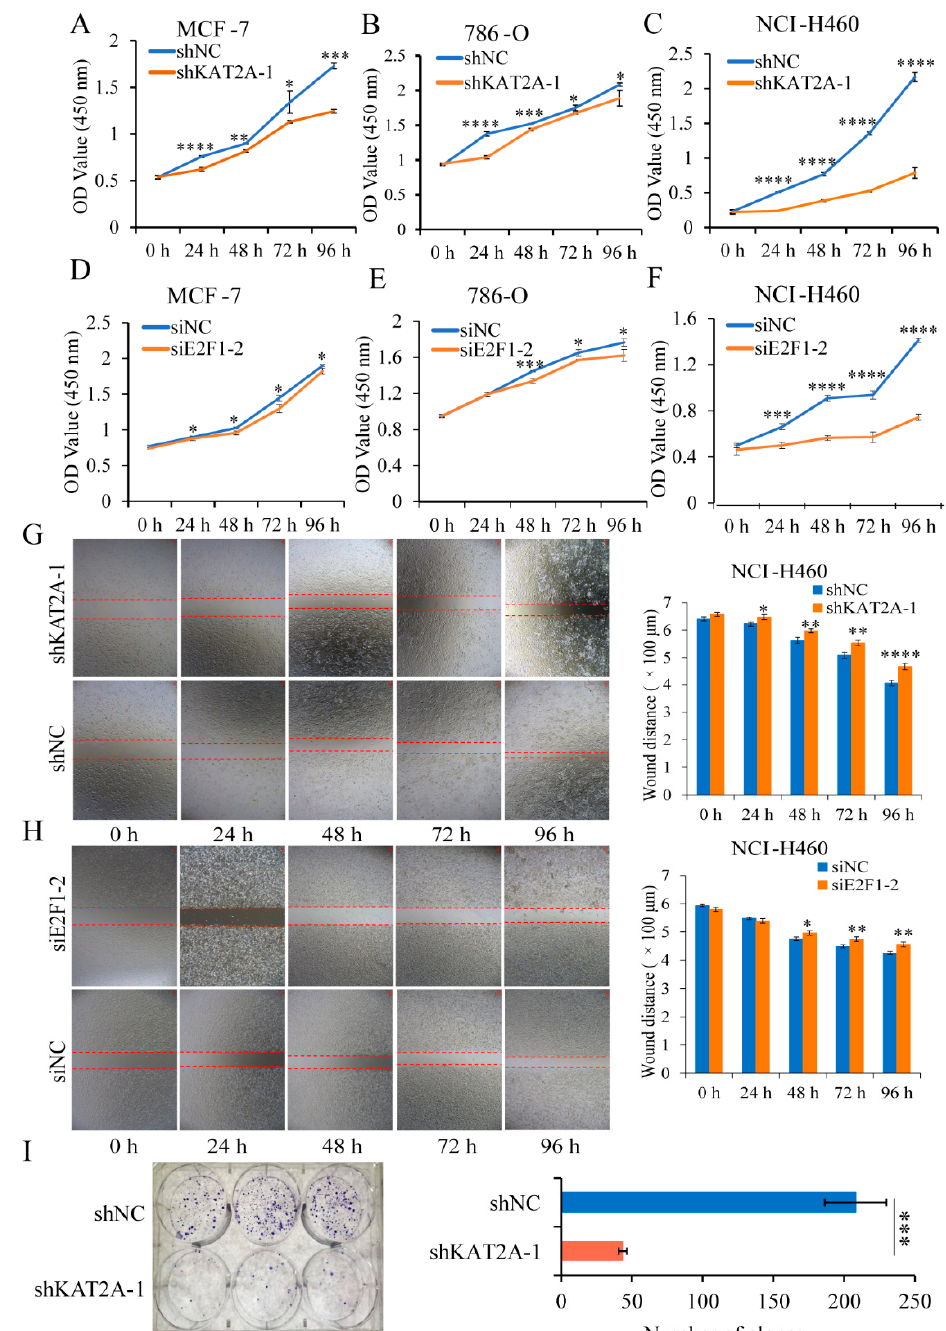
Figure 2. Interfering with KAT2A and E2F1 could significantly inhibit the proliferation and migration of cancer cells. ( A – C ) After transfection of shNC and shKAT2A-1, the cell proliferation ability of MCF-7 ( A ), 786-O ( B ), and NCI-H460 ( C ) were observed using CCK-8. ( D – F ) After transfecting siNC and siE2F1-2, the cell proliferation ability of MCF-7 ( D ), 786-O ( E ), and NCI-H460 ( F ) was detected by CCK-8 assay. Data are representative from at least six independent experiments. The NCI-H460 cells’ migration ability after interference with KAT2A ( G ) and E2F1 ( H ), and their negative control (NC), respectively. Data are representative from three independent experiments. ( I ) Clone formation of NCI-H460 cells with a stable knockdown of KAT2A-1 and NC. Data are representative from three independent experiments. The statistical significance was analyzed by Student’s t -test (one-tailed) analysis. *: p < 0.05; **: p < 0.01; ***: p < 0.001; ****: p < 0.0001.